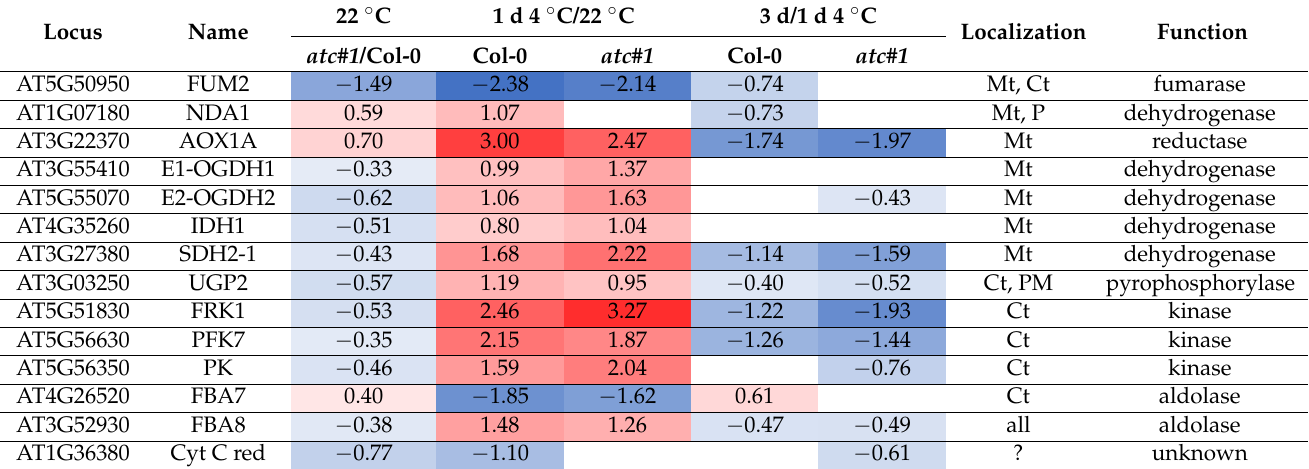
Table 3. DEGs involved in central carbohydrate metabolism and respiration. Selected genes (p adj. < 0.05) are